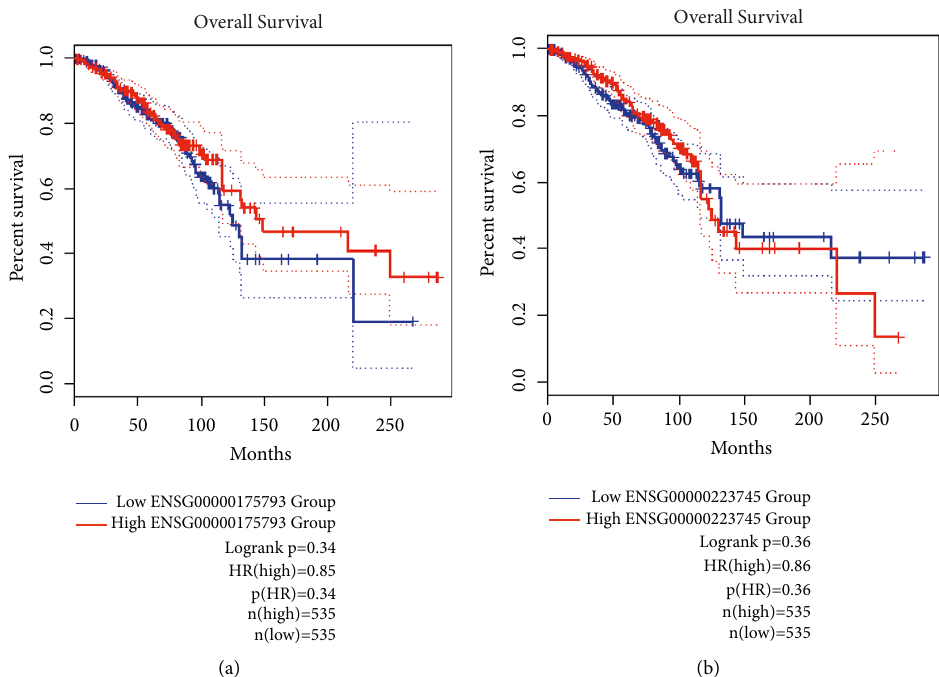
Figure 8: The overall survival (OS) analyses based on the cancer type in BC using GEPIA2 data. (a) SFN , (b) CCDC18-AS1.